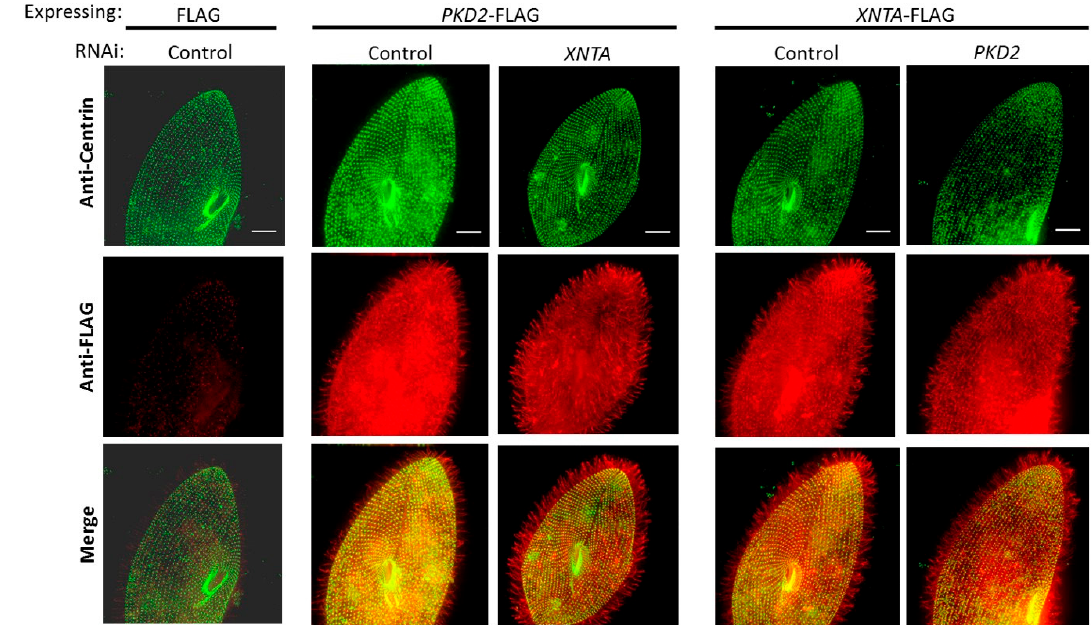
Figure 2. Pkd2-FLAG and XntA-FLAG are found in the cilia and at the cell surface while depletion of XNTA or PKD2 , respectively, does not alter their location. Representative immunofluorescence images are stacks of 7 to 10 Z sections of cells over-expressing FLAG, PKD2 -FLAG, or XNTA -FLAG fed RNAi bacteria before being collected and immunostained. Cells over-expressing FLAG fed the empty RNAi vector (control) serve as the negative control. PKD2 -FLAG or XNTA -FLAG over-expressing cells fed the empty RNAi vector (control) serve as positive controls. Cells over-expressing PKD2 -FLAG or XNTA -FLAG were depleted in XNTA or PKD2 , respectively. Cells were stained with anti-centrin (green) to highlight the basal bodies just below the cell surface and with anti-FLAG (red) to show the epitope-tagged protein. Scale bars represent 15 µm.